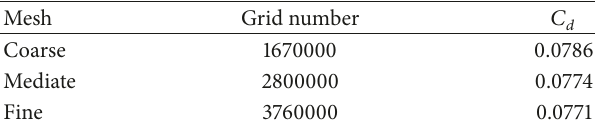
Table 2: Results of the mesh verification